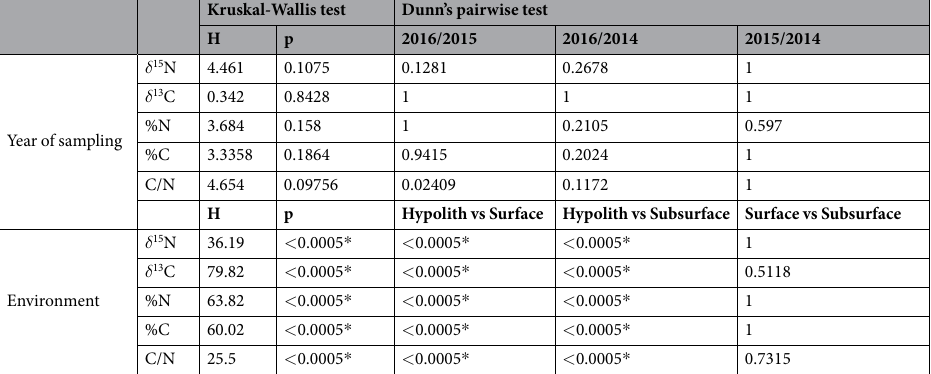
Table 1. Kruskal-Wallis H test results testing the effect of the year of sampling and of the environment on C and N chemistry with Dunn’s pairwise comparison test results. H: Kruskal-Wallis test H(chi 2 ) statistic. * Significantly different (p <